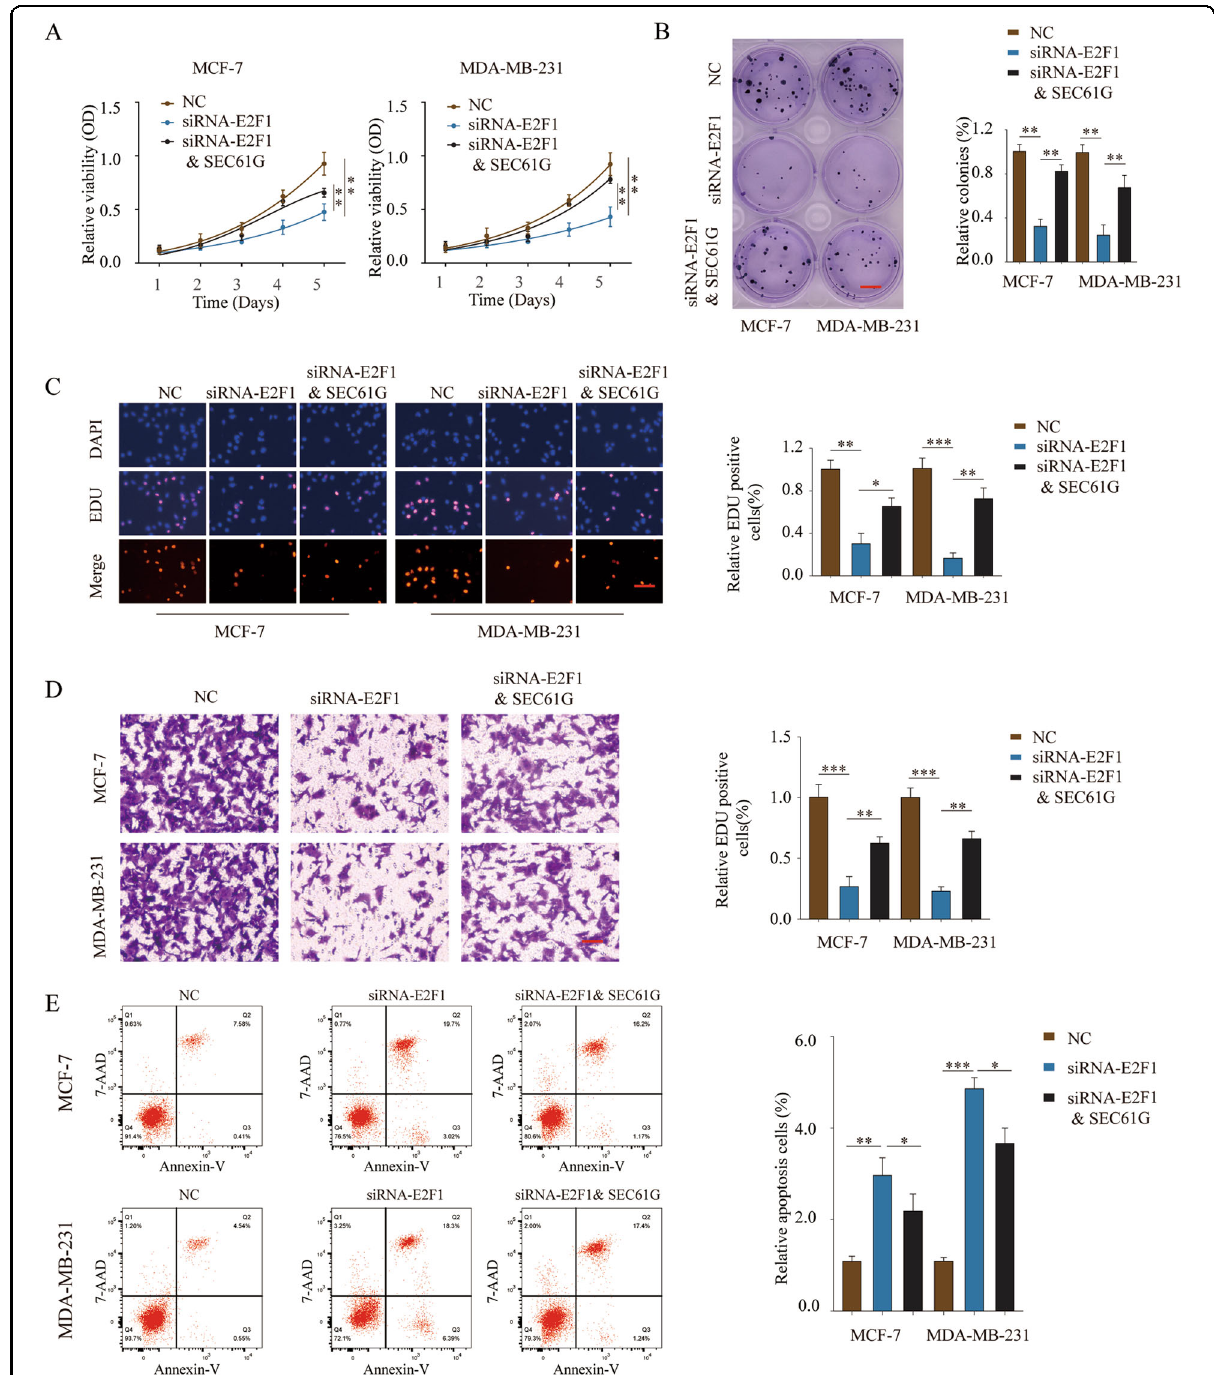
Fig. 7 SEC61G antagonizes the effect of E2F1 knockdown in regulating breast cancer cell proliferation, invasion, and apoptosis. MCF-7 or MDA-MB-231 cells were transfected with negative control (NC), siRNA-E2F1, or siRNA-E2F1 & SEC61G overexpression plasmid. A Cell proliferation was analyzed by CCK-8 assay at the indicated time points. B DNA synthesis was analyzed by the EDU incorporation assay. C Cell growth was assessed by colony formation assay. D Cell invasion was assessed by transwell assay. E Cell apoptosis was analyzed by Annexin V/7-AAD double staining. * P < 0.05, ** P < 0.01, *** P <